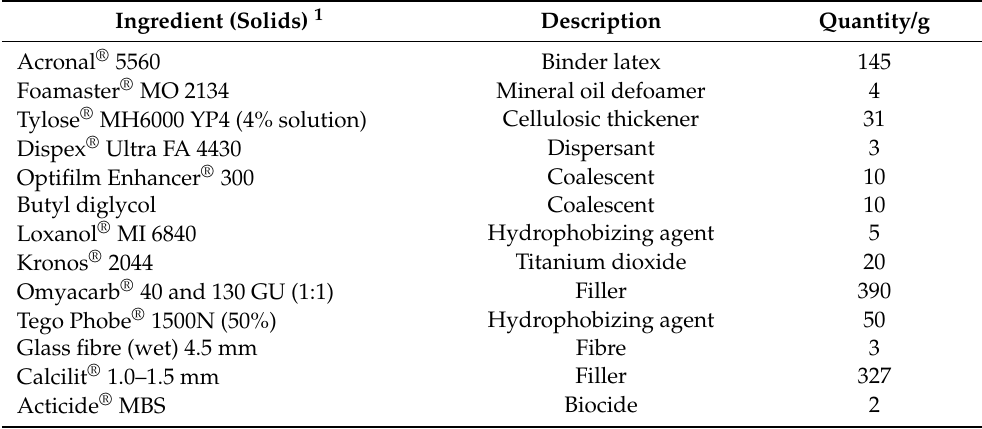
Table A4. Render formulation for binders G and H. The solids content was 82.2%; the pH was adjusted to 8.2–8.5 using ammonia (and to pH 10 in the case of D2). All brand names are each respective trademarks of the following companies: Eastman Chemical Inc. (Optifilm Enhancer ® ), Alpha Calcit Füllstoff GmbH (Calcilit ® ) (Köln, Germany), Evonik SE (Tego Phobe ® ) and Thor GmbH (Acticide ® ) (Speyer, Germany). The 4.5 mm glass fiber (wet) was obtained from Schwarzwälder Textil-Werke, Schenkenzell, Germany. The renders can further be formulated with Acronal 5560 and also according to the background given on the renders in Refs.